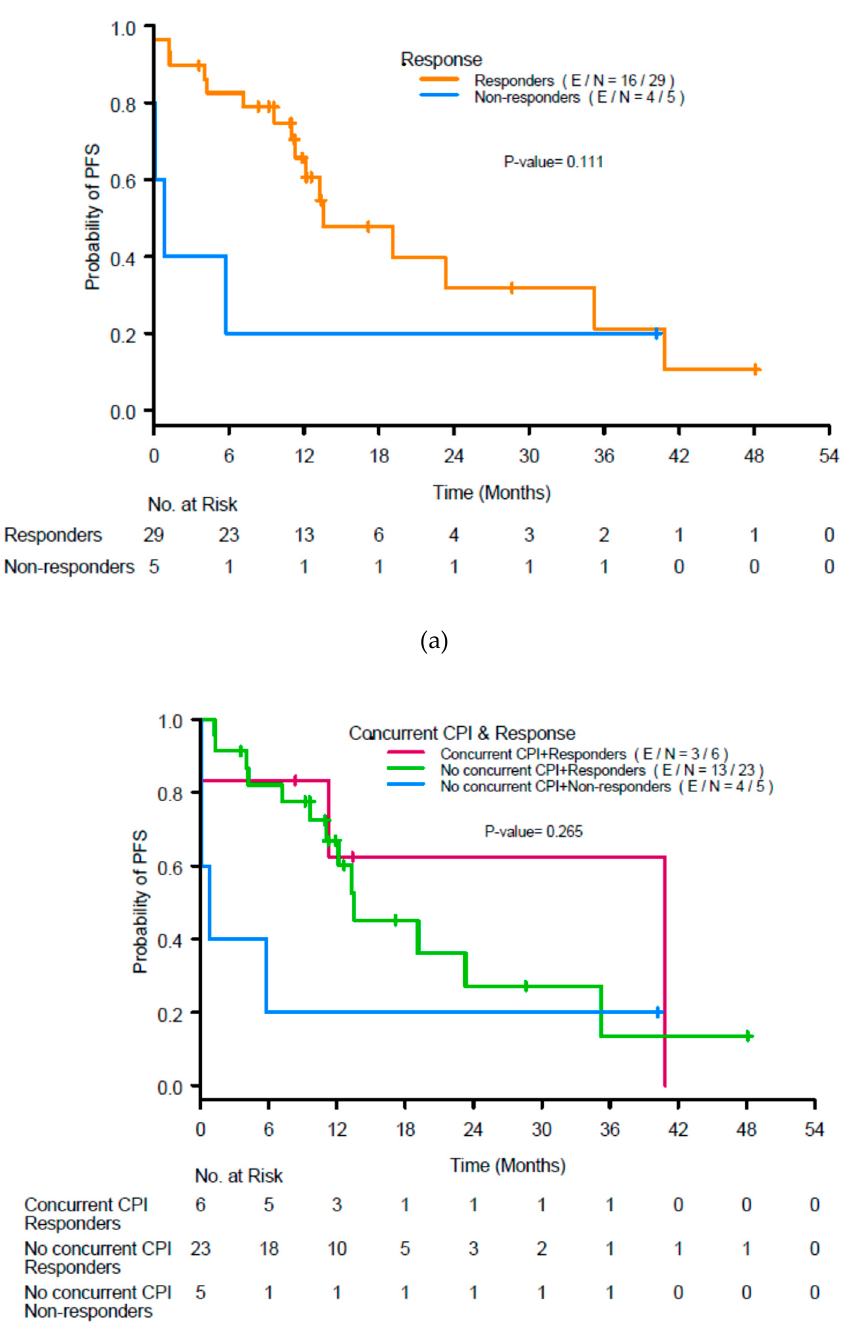
Figure 4. ( a ) Kaplan-Meier curves for progression-free survival (PFS) by response to treatment for acute interstitial nephritis at 3 months after initiation of treatment and ( b ) renal response and use of concurrent immune checkpoint inhibitors (ICIs). CR, complete response; PR, partial response; NR, no response.